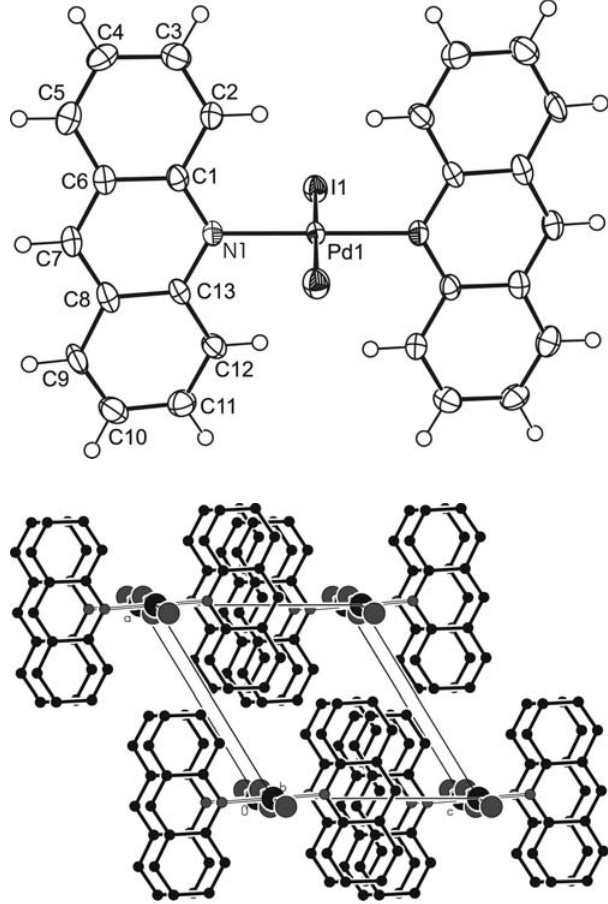
Table 1. Data collection and